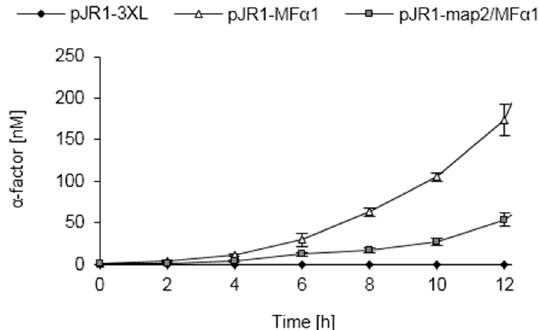
Figure 8. Pheromone secretion of engineered S. pombe strains. S. pombe HE620 was transformed with plasmids pJR1-3XL, pJR1-MF α 1 or pJR1-map2/MF α 1 [82] and grown in minimal medium. At the indicated time points, samples of the culture supernatants were taken and pheromone concentrations